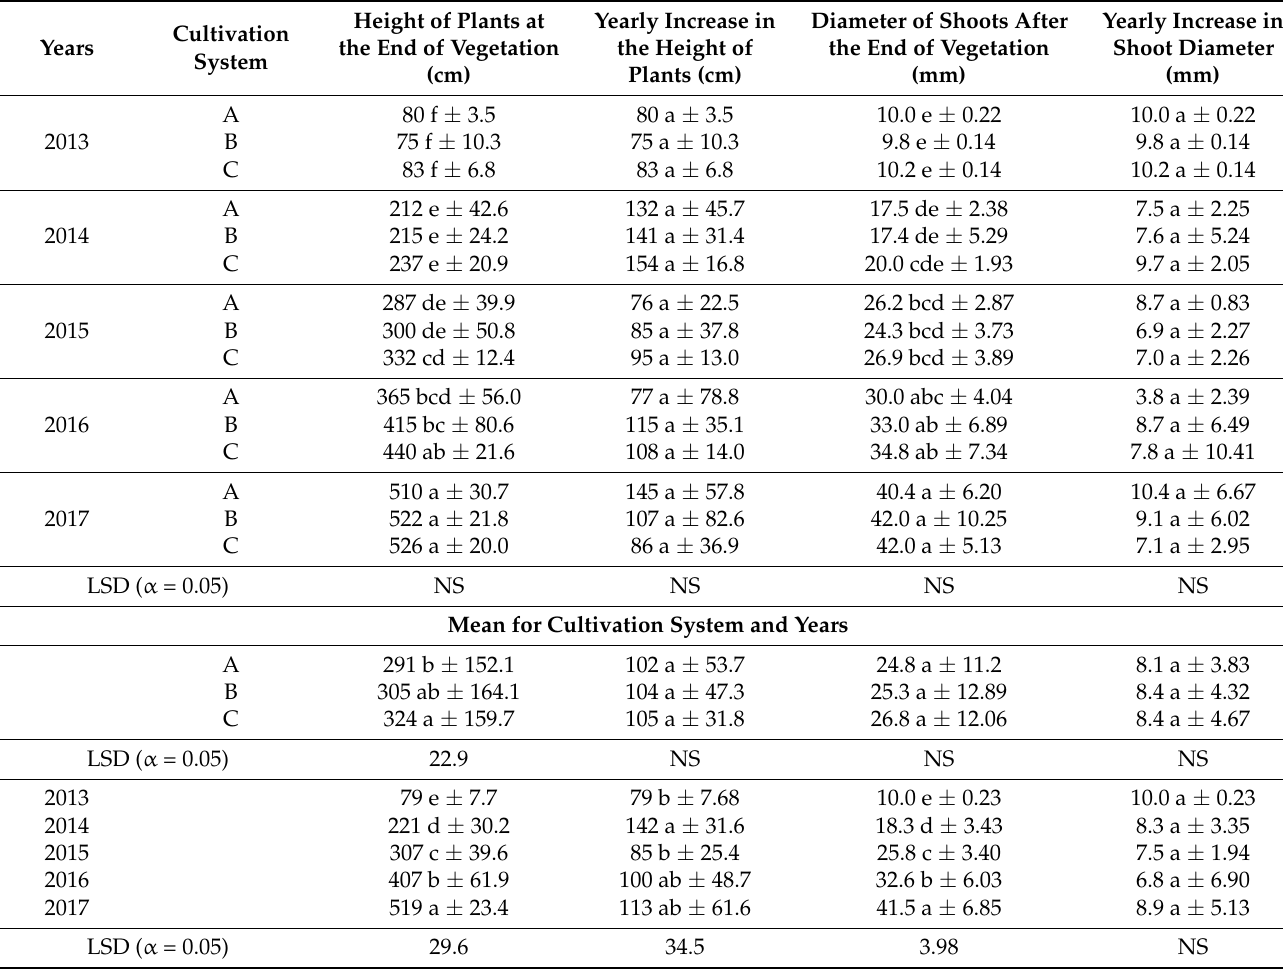
Table 6. Influence of undersowing cultivation and nitrogen fertilization on morphological traits of willow